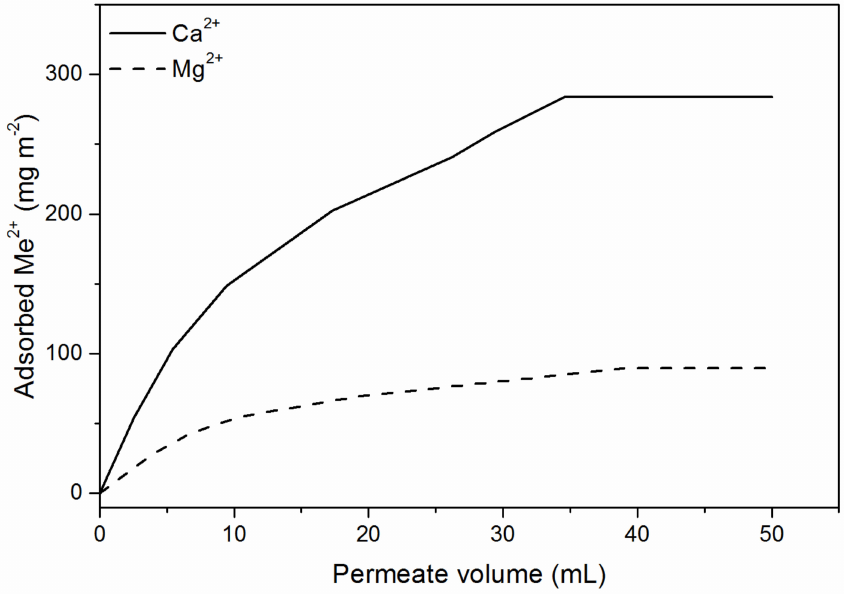
Figure 6. Adsorption of (full line) Ca 2+ or (dashed line) Mg 2+ ions onto PT-CNF nanopaper with 17 gsm per unit membrane area vs. permeate